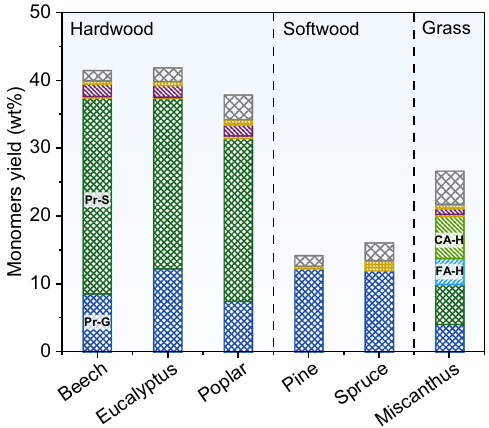
Fig. 6 | Stability and reusability of RuN/ZnO/C catalyst. Reaction conditions: birch wood (250mg), RuN/ZnO/C (25mg, 10wt%), MeOH (15mL), 240°C, H 2 (3MPa at 25°C), and 4h.